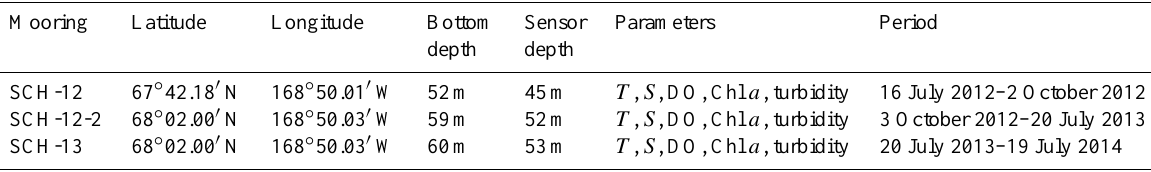
Table 1. Mooring configurations.